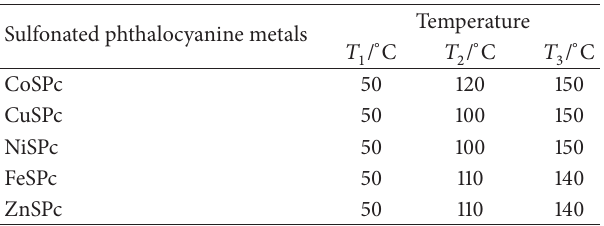
Table 1: Reaction temperature for the preparation of sulfonated phthalocyanine